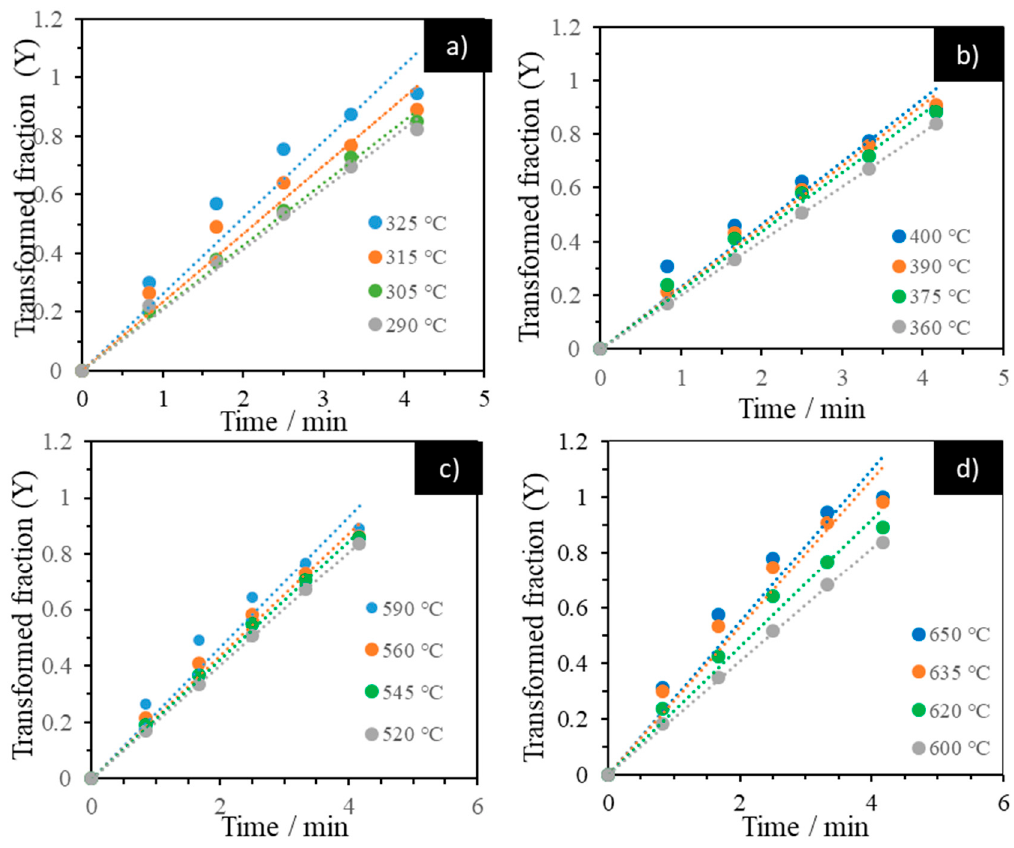
Figure 6. Reacted fraction of mercury jarosite obtained isothermally as function of time for the observed mass loss events: ( a ) first event, ( b ) second event, ( c ) third event, and ( d ) fourth event. The “time to given fraction” method relates t Y to Y = 0.5 for each temperature.